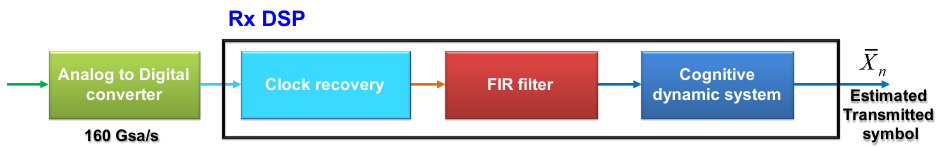
Figure 15. Receiver with cognitive dynamic system and OTDM digital signal processing (DSP).